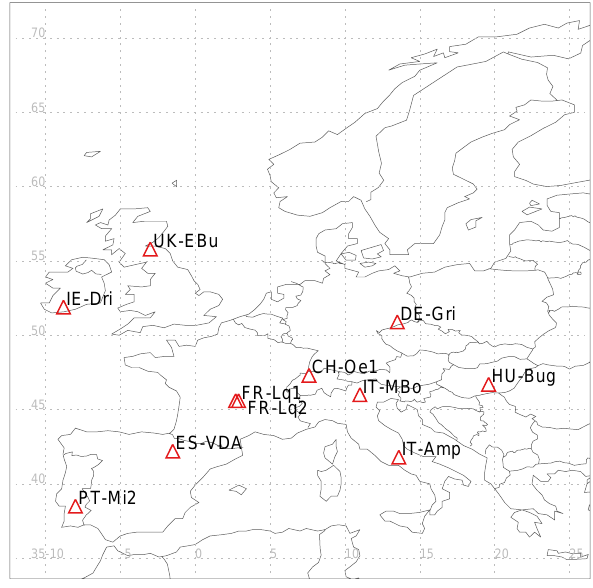
Fig. 2. Distribution of the 11 European grassland sites in this